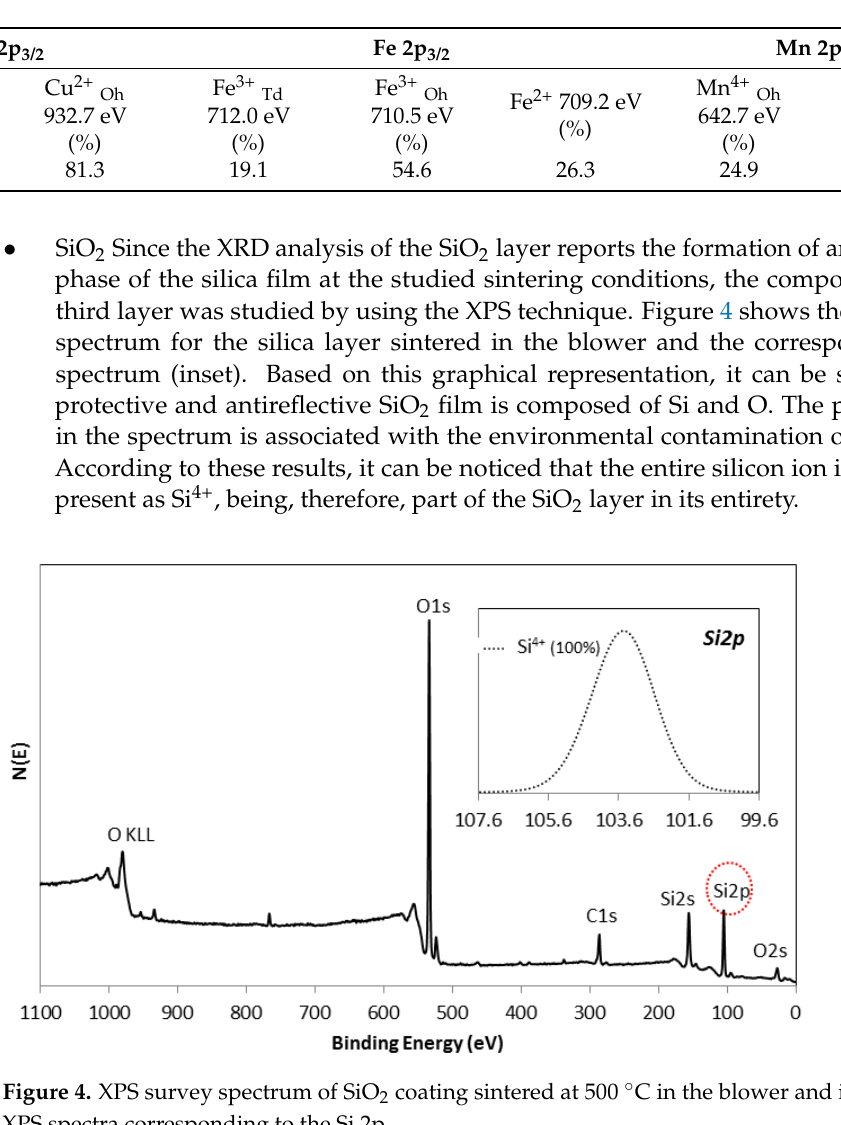
Table 2. Oxidation state and site distribution of iron, manganese and copper ions in FeMnCuO x thin film.